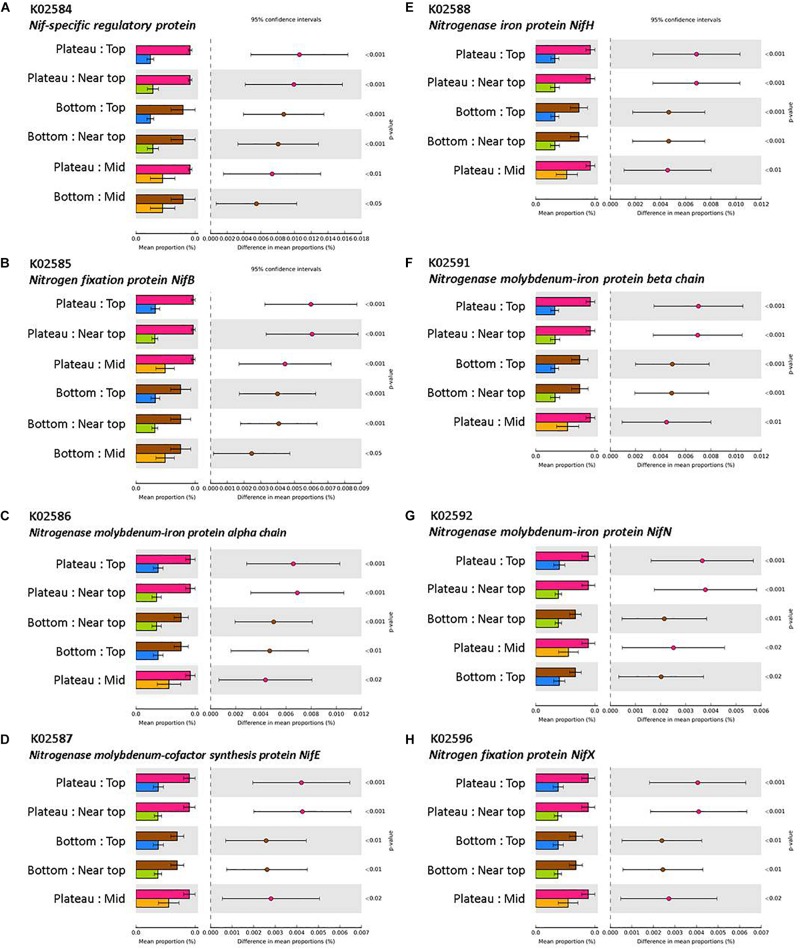
KEGG orthologs (KOs) involved in N-fixation via (A) Nif-specific regulatory protein, (B,H) Nitrogen fixation protein NifB and NifX, (C,F,G) Nitrogenase molybdenum-iron protein alpha chain, beta chain, and NifN, (D) Nitrogenase molybdenum-cofactor synthesis protein NifE, (E) Nitrogenase iron protein NifH, with significantly higher abundances in the plateau and bottom sections relative to all others (top, near top, and mid) on T140. KO abundances were calculated using PICRUSt and visualized in STAMP (minimum effect size = 0.7, Benjamini–Hochberg multiple test-corrected q-value < 0.05).